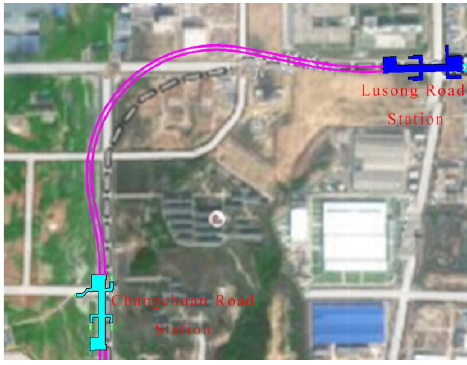
Figure 1. Reality view of a tunnel with a small curve radius.